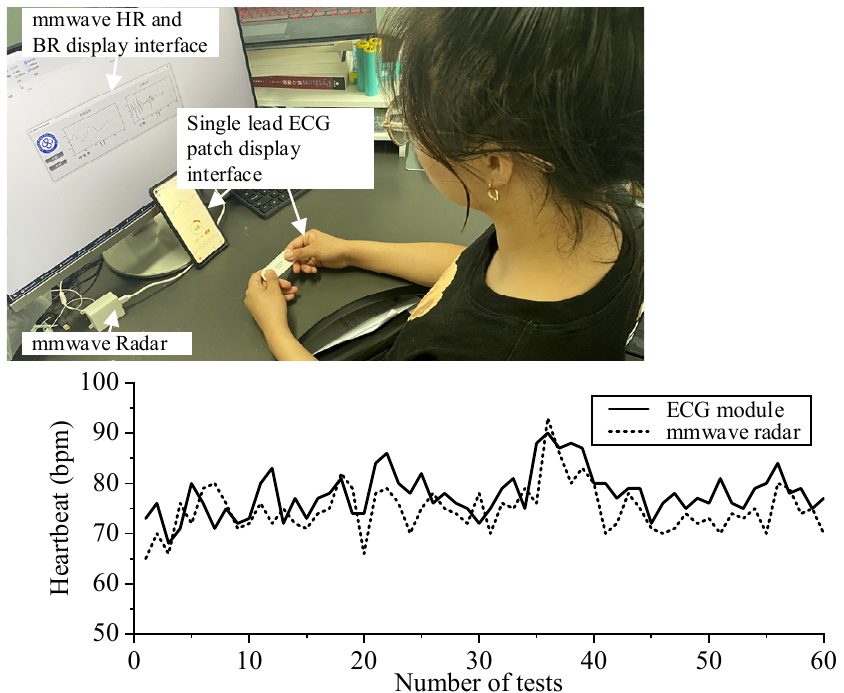
Figure 19. Tester 1.the comparative experiment of millimeter wave radar and single channel ECG module.